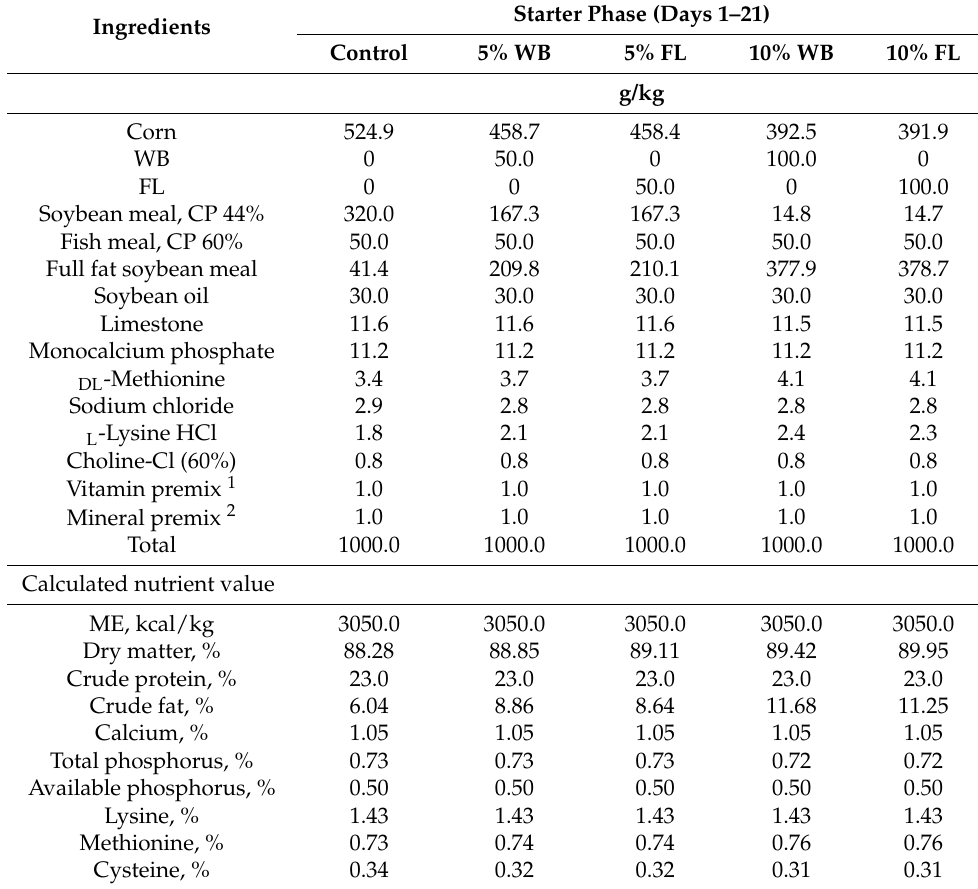
Table 1. Ingredients of the experimental diets for broilers at the starter phase (days